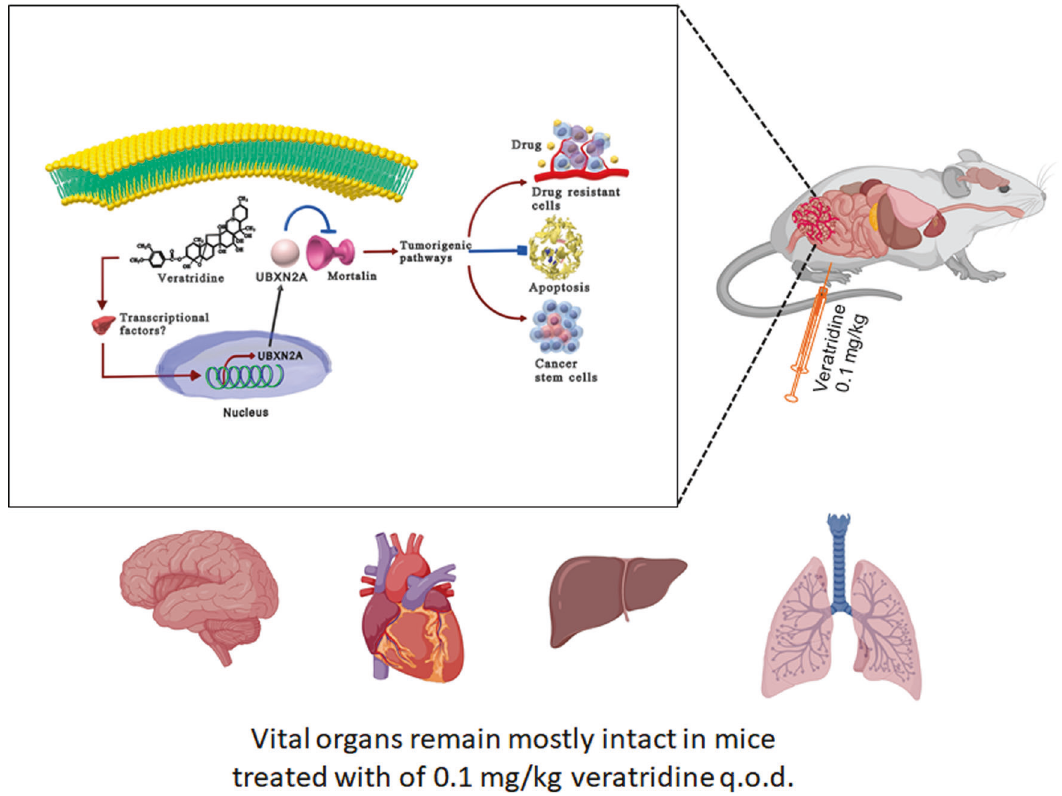
Fig. 8 Diagrammatic representation of anti-cancer mechanism of action of VTD. This schematic shows the potential anti-tumorigenic function of VTD in a xenograft mouse model of human cancer created with Biorender.com. A 0.1 mg/kg dose of VTD increases transcription and protein expression of UBXN2A in human cancer cells originated from the epithelial cells lining the colon. Enhanced UBXN2A binds to a well-studied oncoprotein, mortalin, and suppresses mortalin ’ s tumorigenic functions. Mounting evidence indicates that the inhibition of mortalin leads to cell apoptosis, suppression of cancer stem cells (CSCs), and reduction of drug resistance. Meanwhile, VTD showed no signi fi cant toxicity toward vital organs, such as the heart, brain, liver, or lung. Further studies in CRC animal models will pave the way to clinically translate the use of VTD for CRC patients in the near